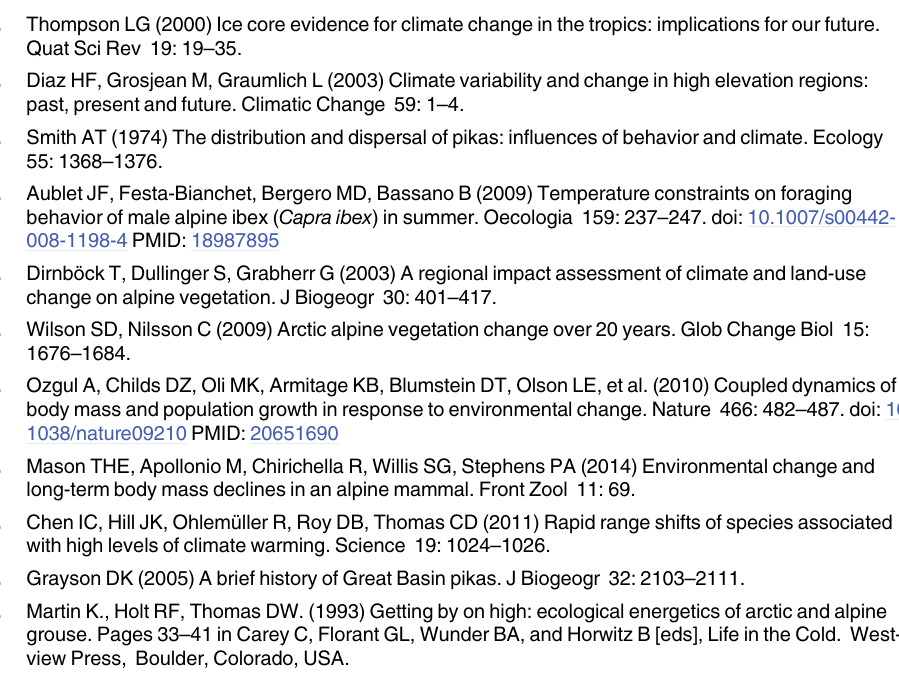
S2 Table. Full candidate model set.